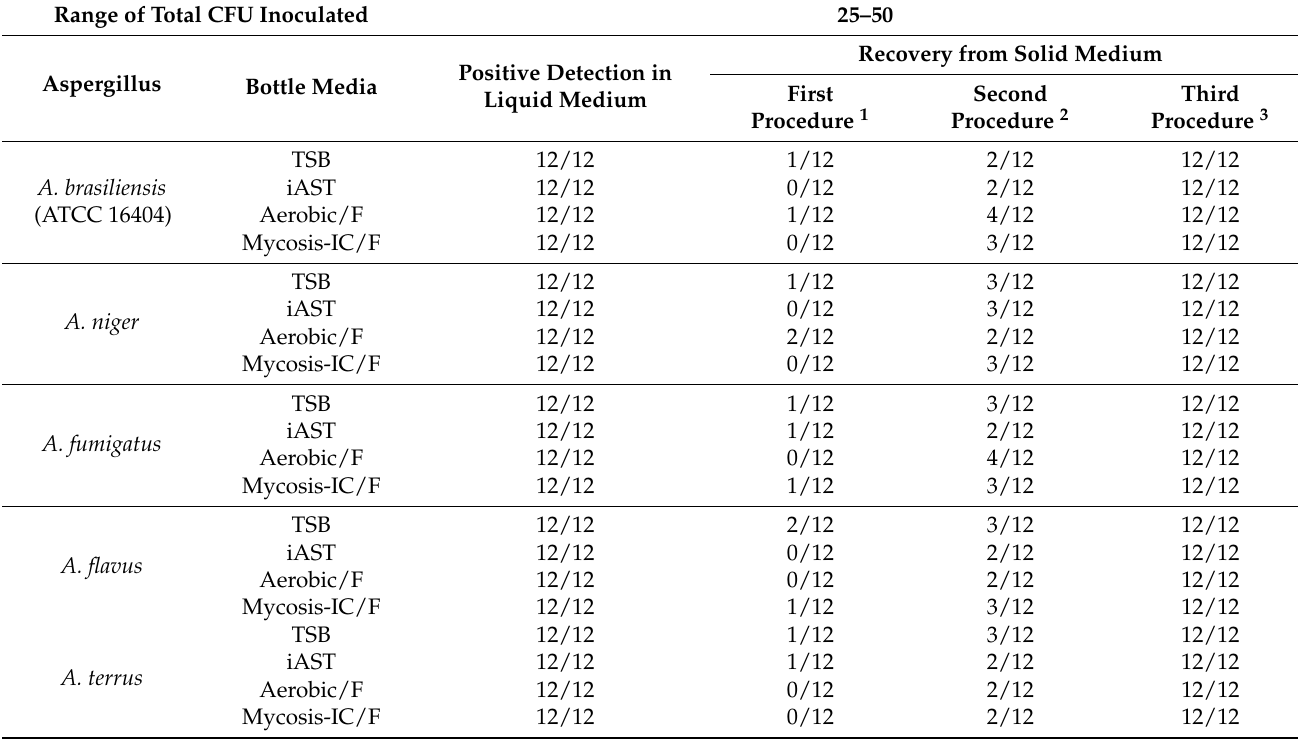
Table 4. Recovery of Aspergillus spp. from solid